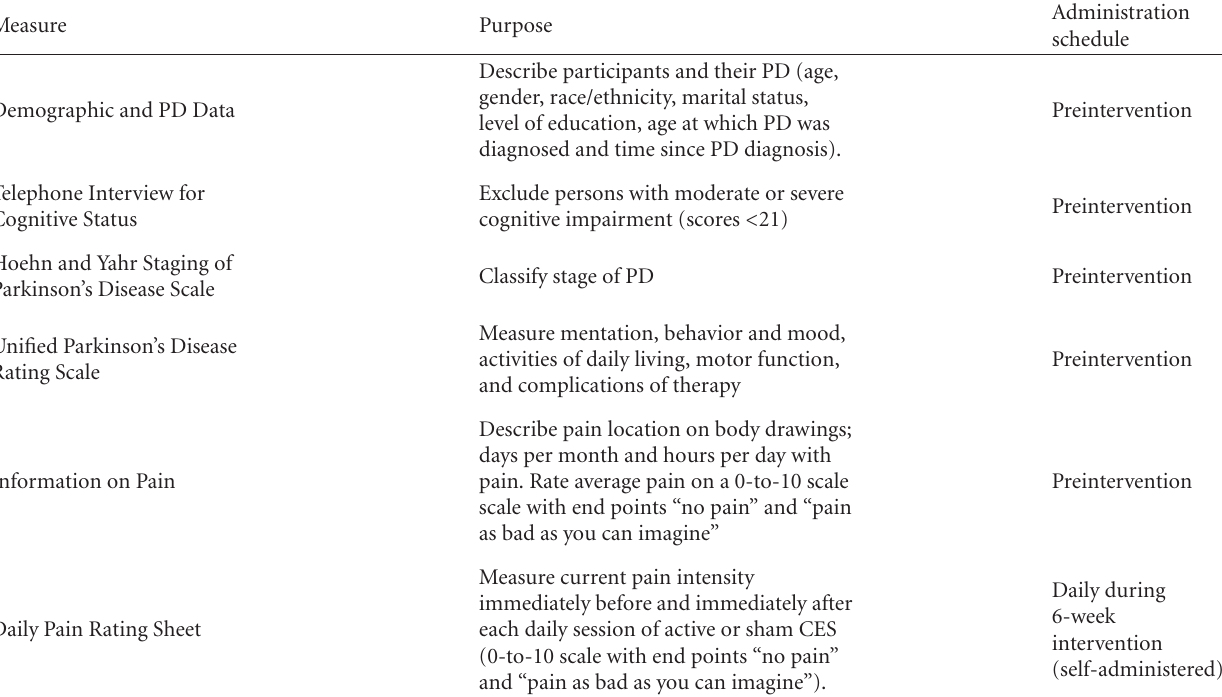
Table 1: Summary of